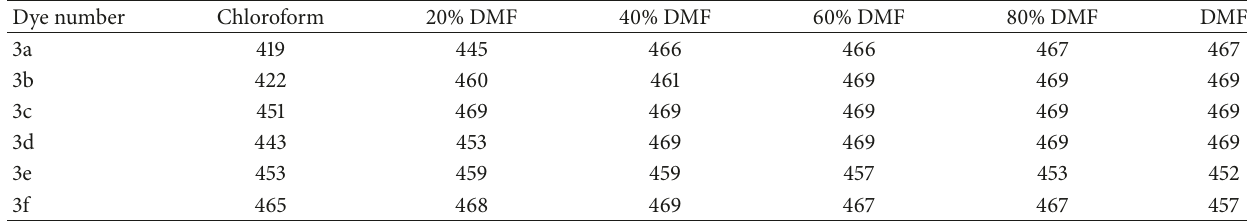
Table 6: The 𝜆 max values of dyes in different percentages of chloroform/DMF mixture.